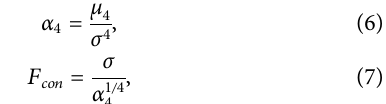
Frontiers in Earth Science |